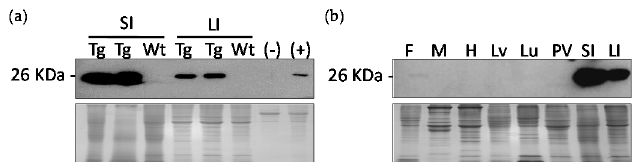
Figure 3. ( a ) Western blot analysis of transgenic Japanese quail intestines compared to wild-type quail intestines. At 26 kDa, eGFP was expressed in the small and large intestine of transgenic quail but not in the wild-type. Coomassie blue staining was utilized to ensure an equal amount of protein was loaded for each sample; ( b ) Western blot analysis of transgenic quail tissue distribution including fat (F), muscle (M), heart (H), liver (Lv), lung (Lu), proventriculus (PV), small intestine (SI), and large